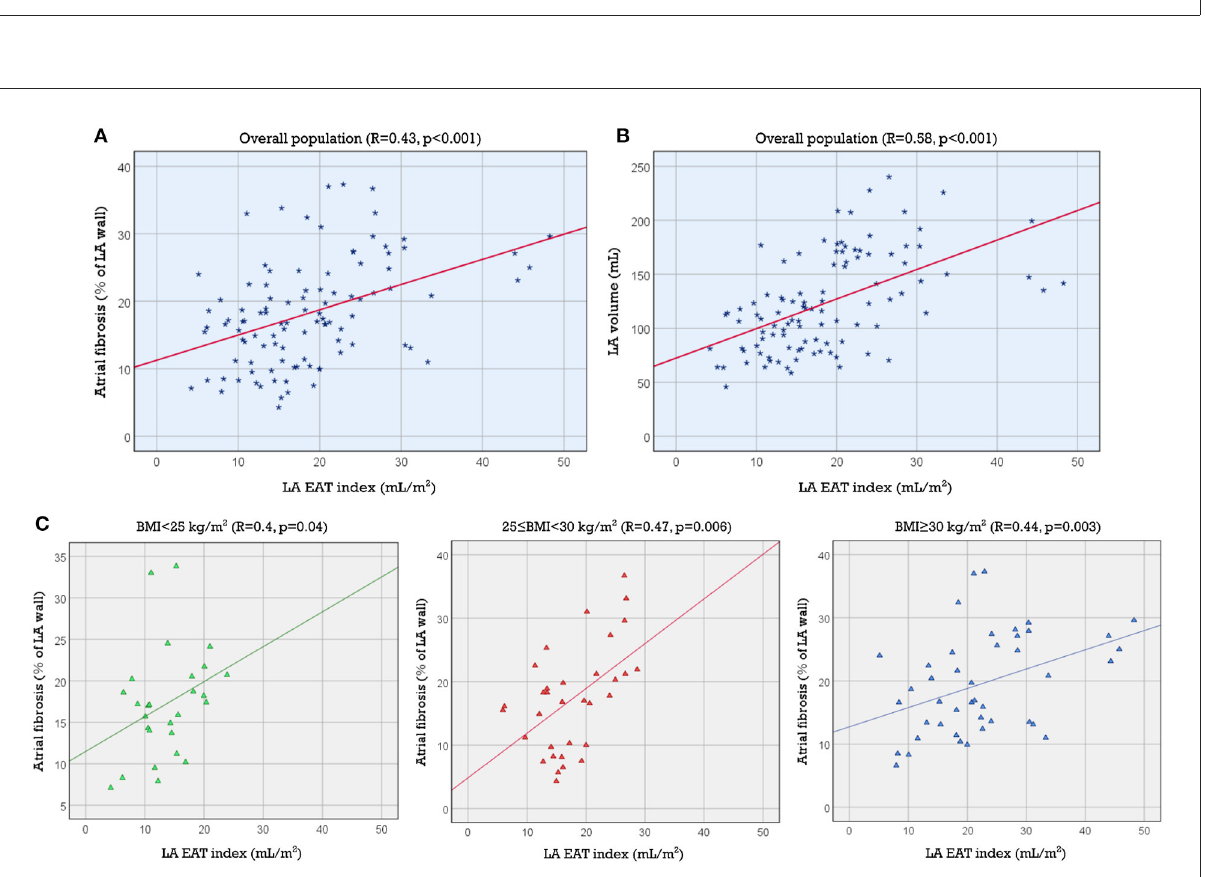
FIGURE2 Association of LA and total EAT volume with BMI. Scatter plots showing the association of BMI with (A) LA EAT volume and (B) total EAT volume. BMI, body mass index; EAT, epicardial adipose tissue; LA, left atrial.